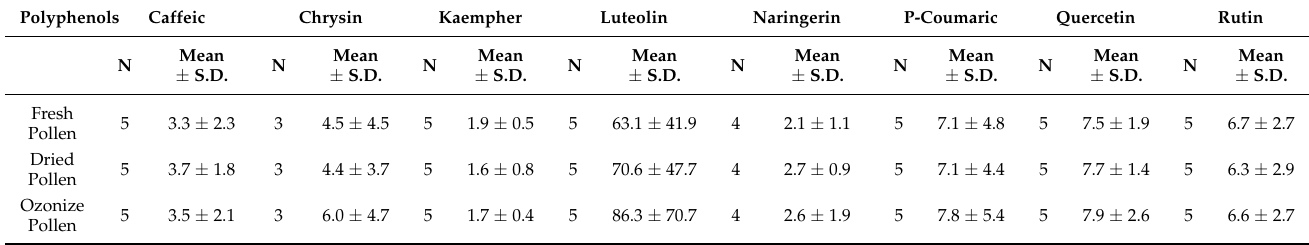
Table 5. Polyphenols in bee-pollen. The presence of polyphenols was quantified in bee-pollen samples: 10 initial samples of fresh-frozen bee-pollen, 10 hot-air dried bee-pollen samples, and 10 ozone exposed bee-pollen samples. The results are presented as number of samples that contain the specific polyphenols (N) and the average (Mean ± S.D.) ( µ g/g dry) for each of polyphenols studied. Gallic Acid, Genistein, and Resveratrol were found below the Limit of Quotation (LOQ) in all the analyzed